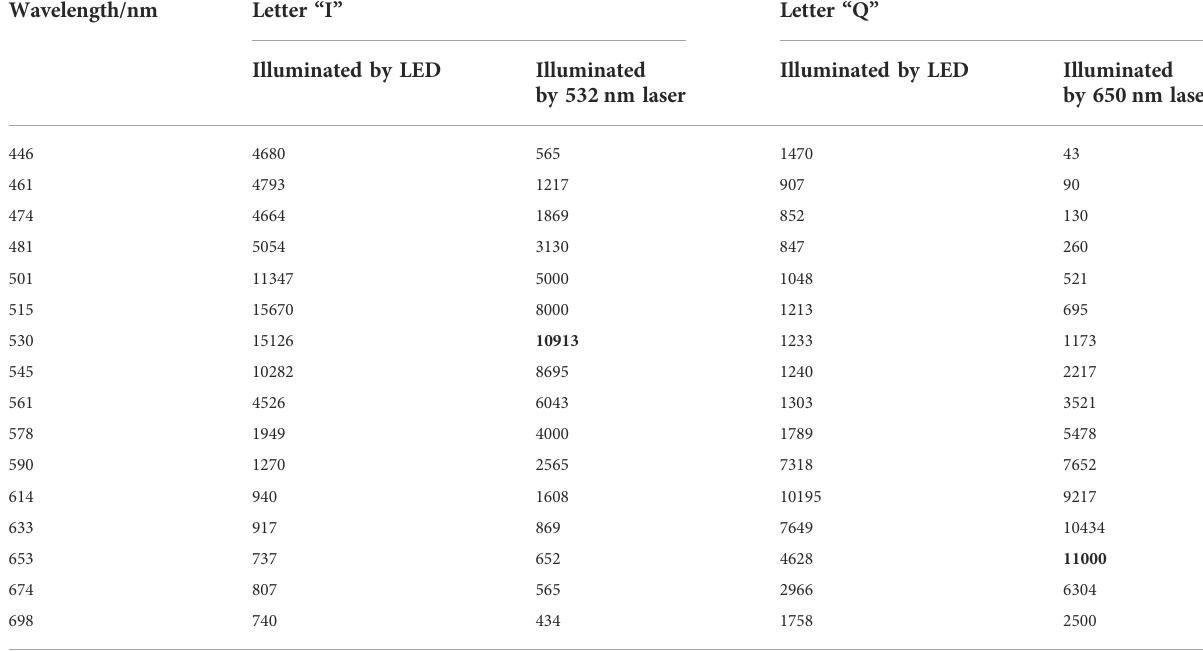
TABLE 1 List of intensity values of targets “ Q ” and “ I ” corresponding to Figure 5. Bold numbers show that the reconstructed intensity values of both letters reach the highest at the wavelengths correspond to the illuminated lasers.